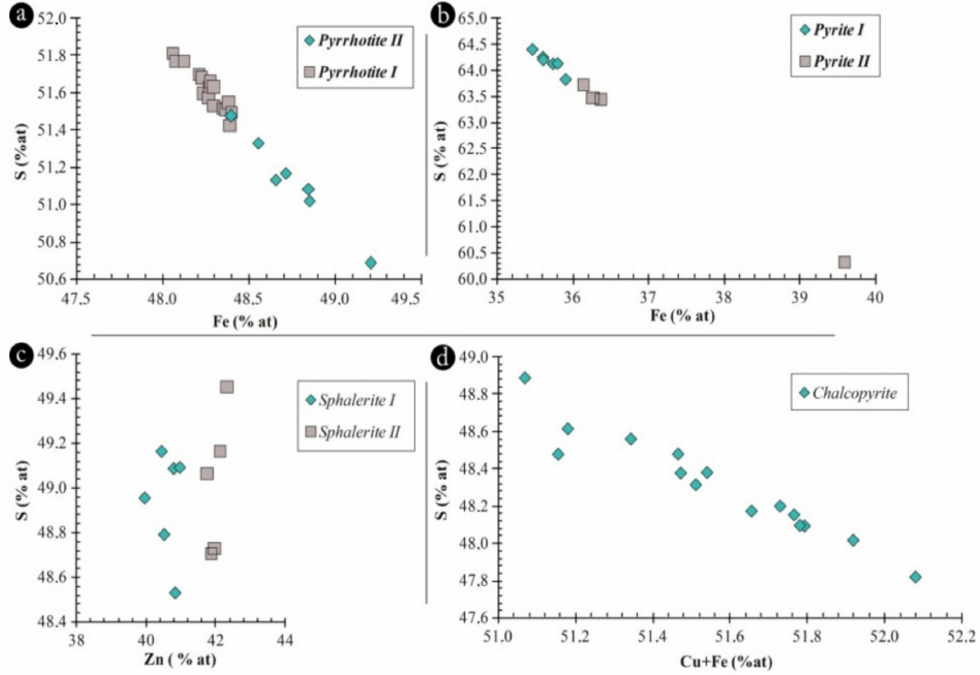
Figure 17. Geochemical data (in %at) for sulfide mineralization of NNE-A. Correlation diagram between Fe and S of pyrrhotites ( a ), between Fe and S in pyrites ( b ), between Zn and S in sphalerites ( c ), between Cu + Fe and S in chalcopyrite ( d